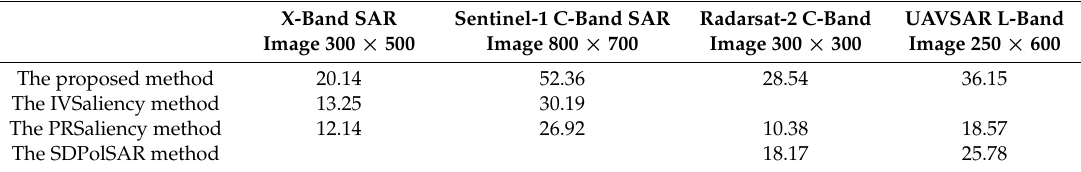
Table 2. Time costs of saliency detection using different methods